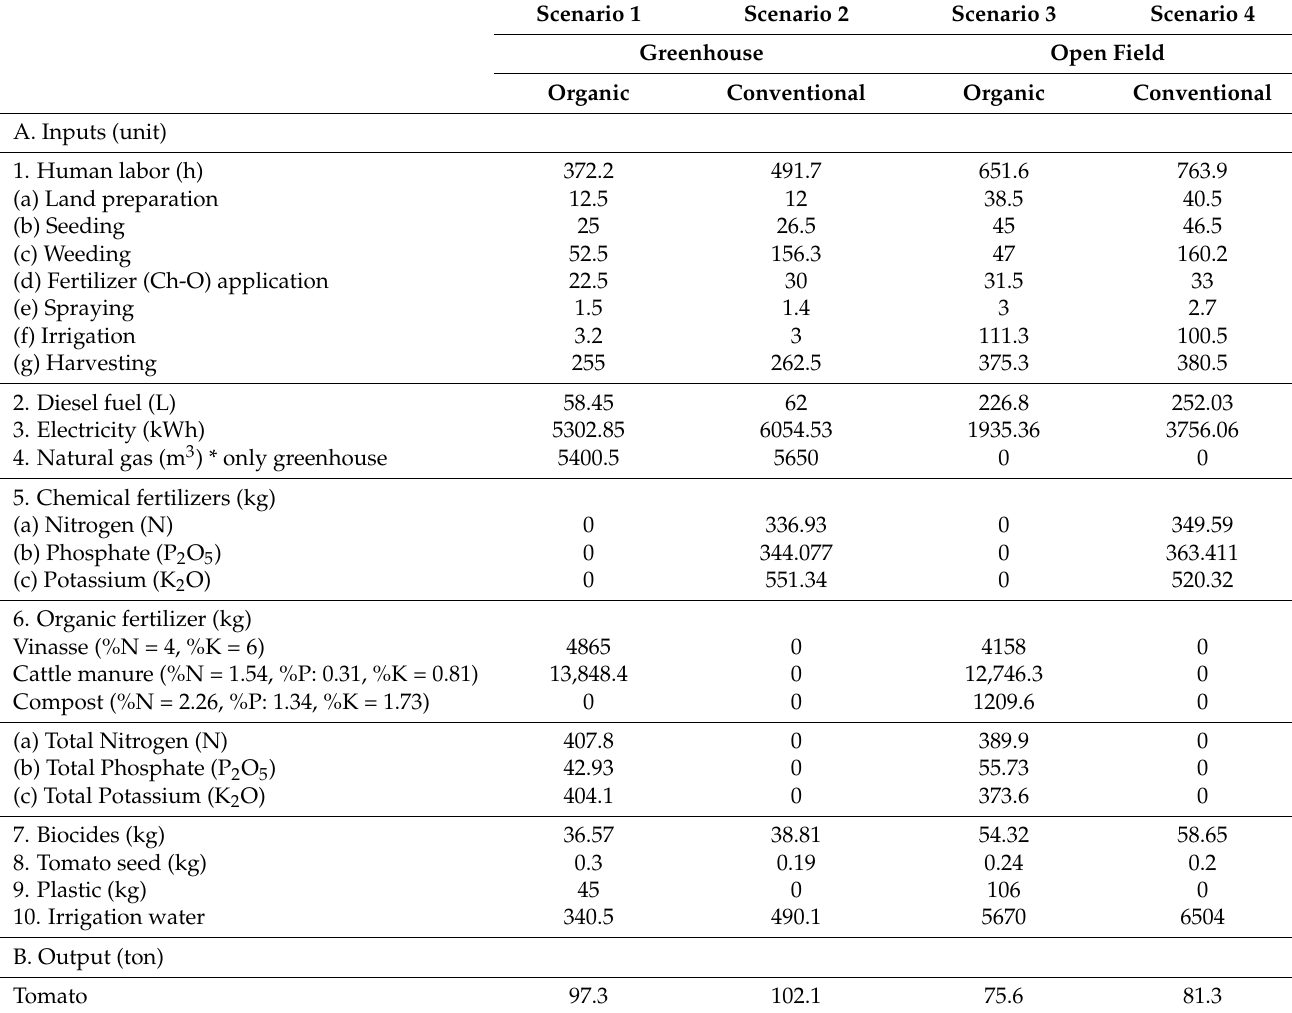
Table 2. The inventory data of tomato cultivation in each scenario per